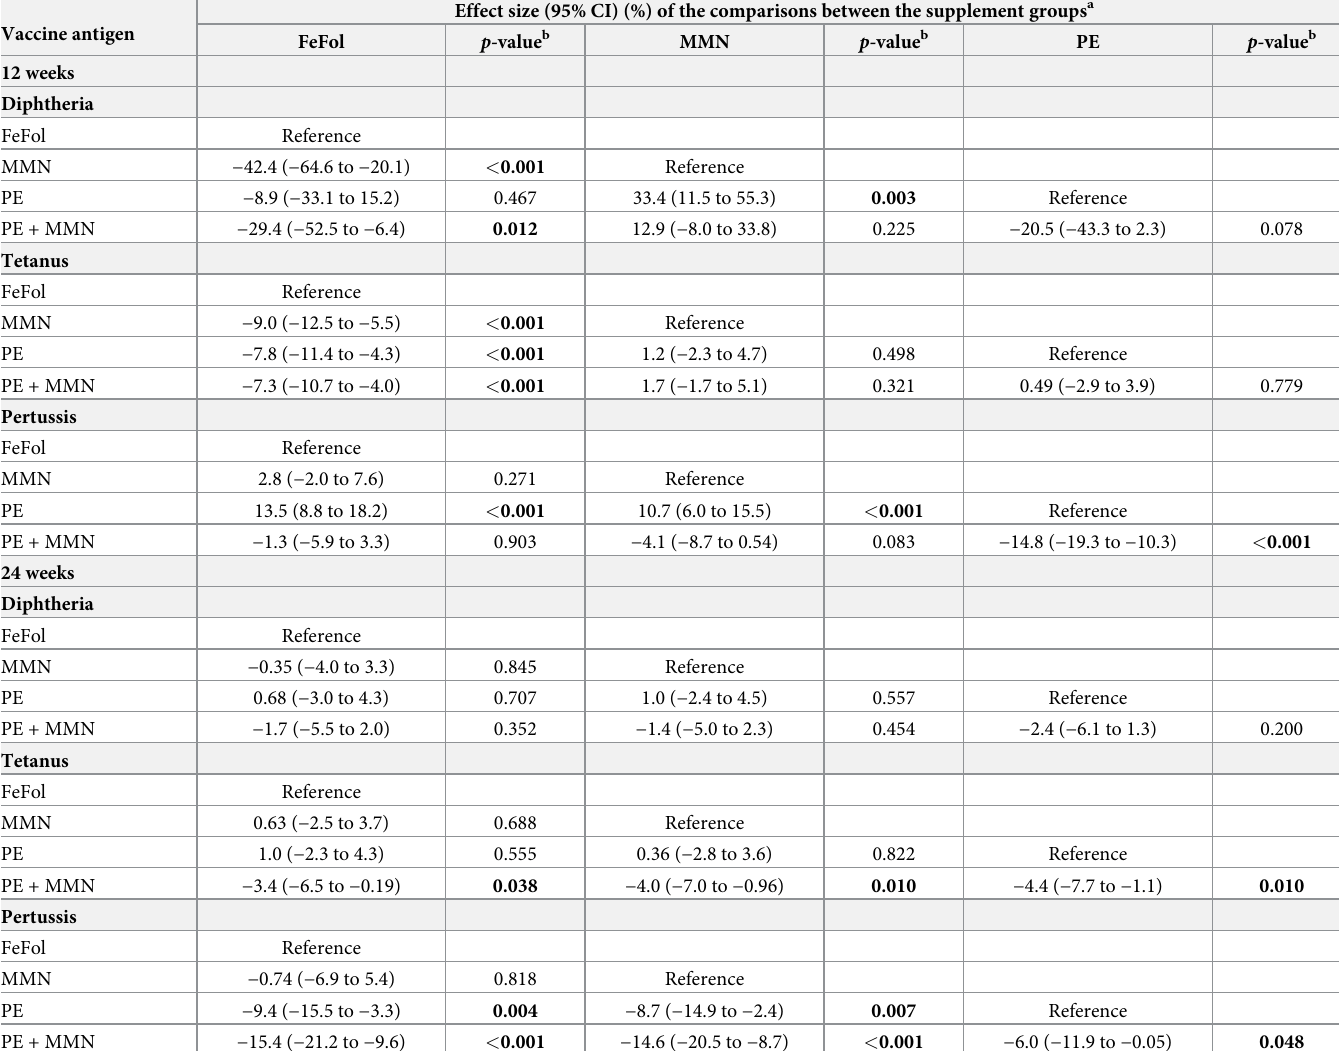
Table 3. Effect size (95% CI) percentage of the comparisons of the mean diphtheria, tetanus, and pertussis antibody titres in infants at 12 and 24 weeks of age across the maternal supplement groups. Effect size (95% CI) (%) of the comparisons between the supplement groups Vaccine antigen